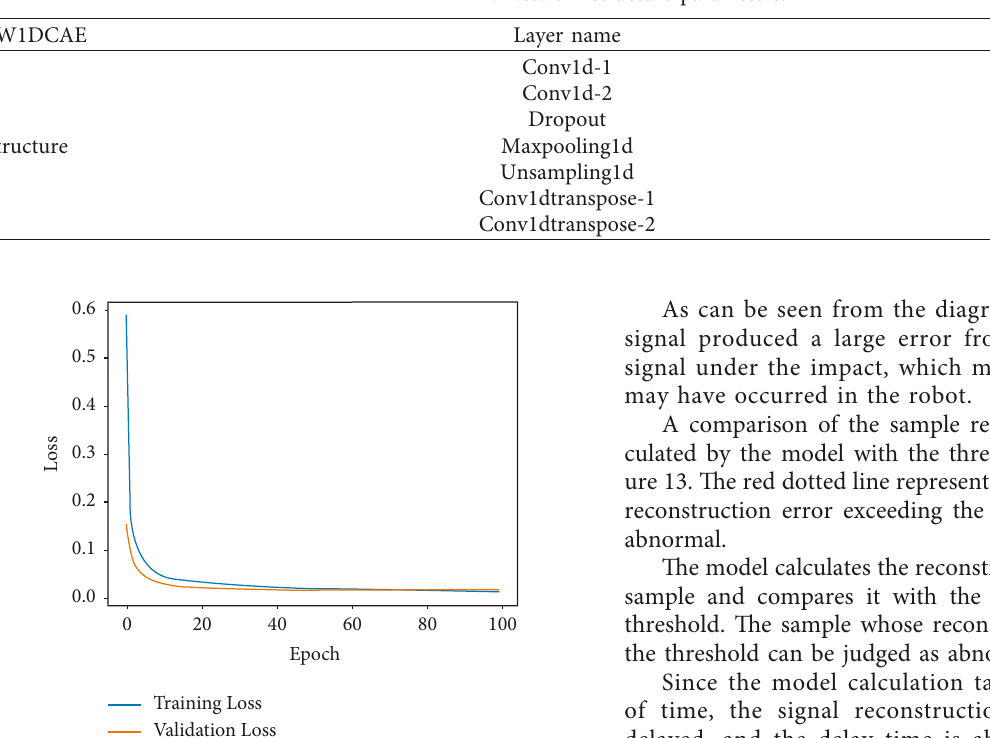
Table 1: Network structure parameters.